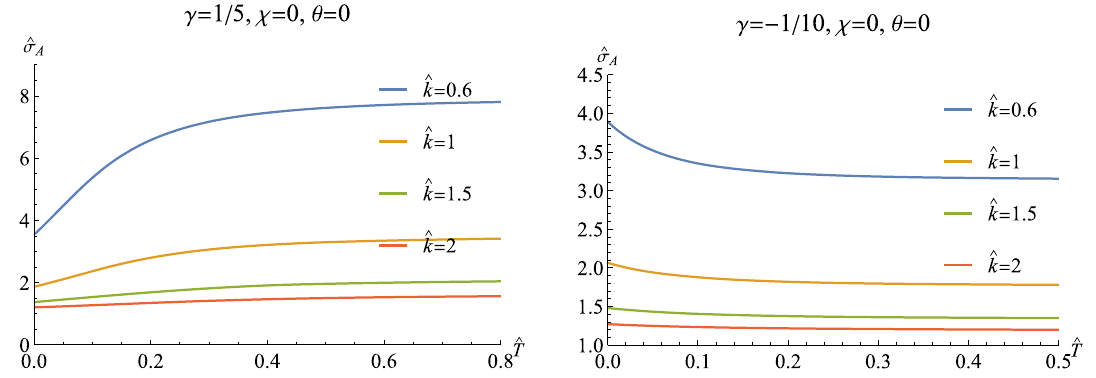
Fig. 2 Electric conductivity ˆ σ A as a function of the temperature ˆ T for varivd different ˆ k at γ = 1 / 5 and − 1 / 10. Here, we’ve set χ = 0 ,θ = 0